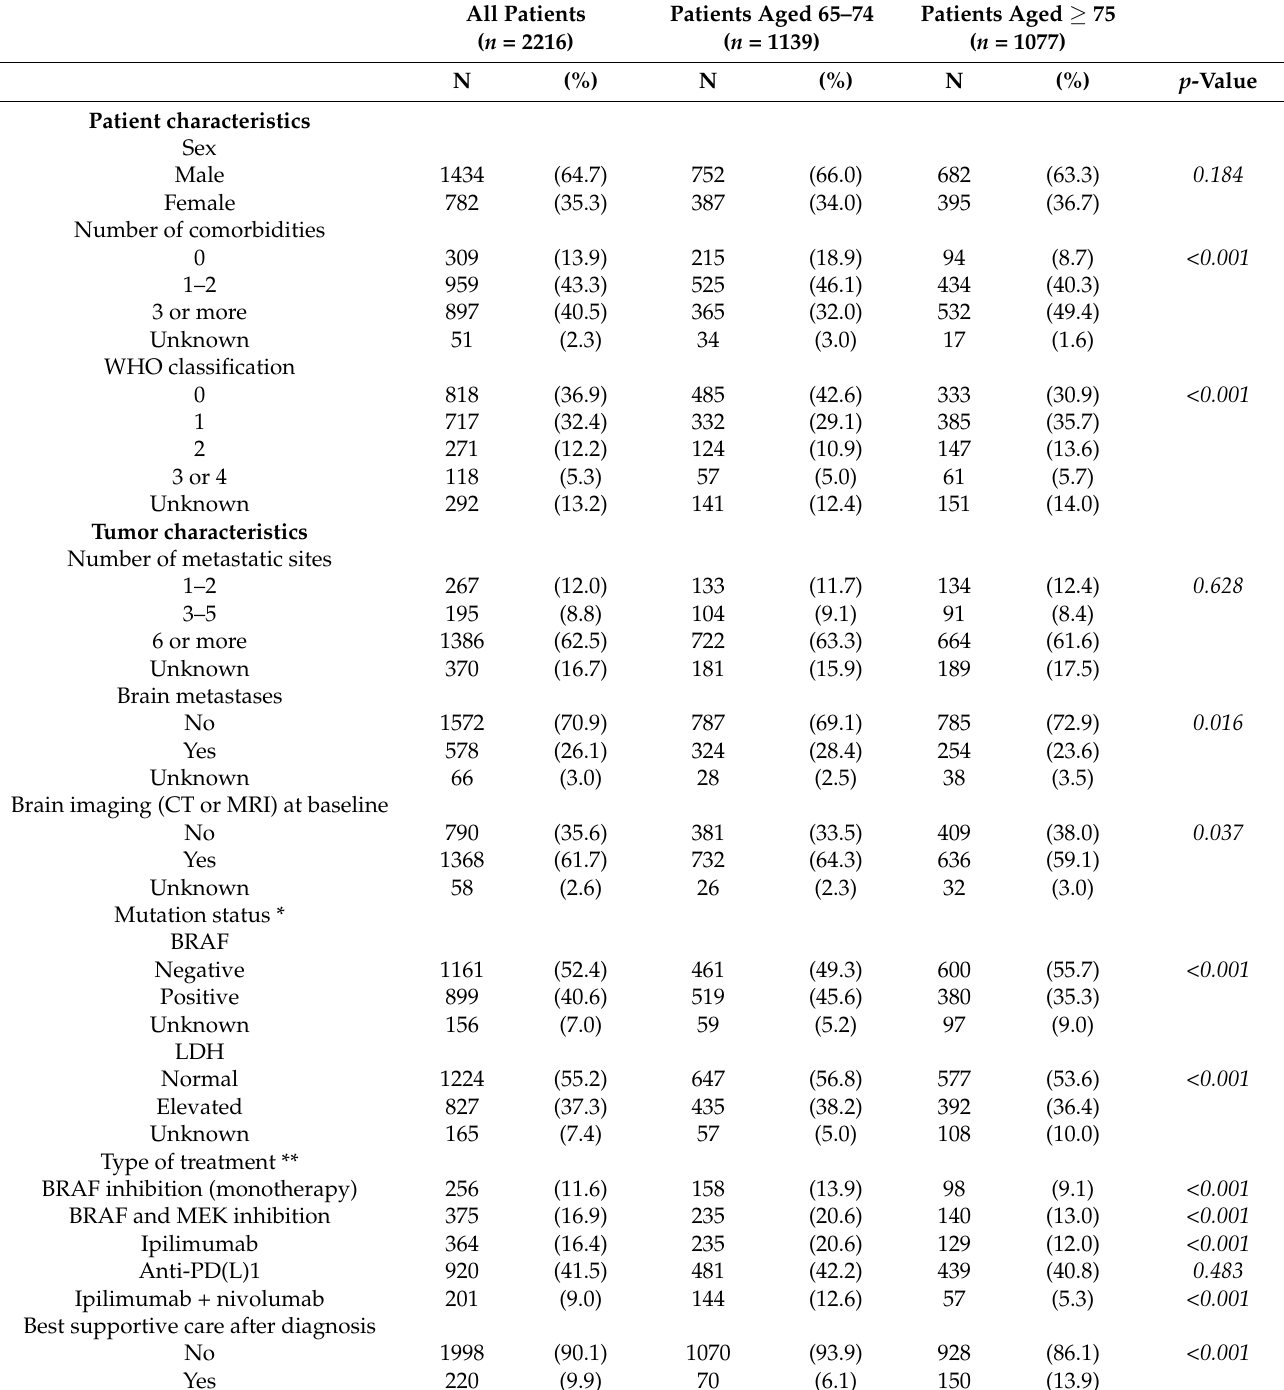
Table 1. Patient